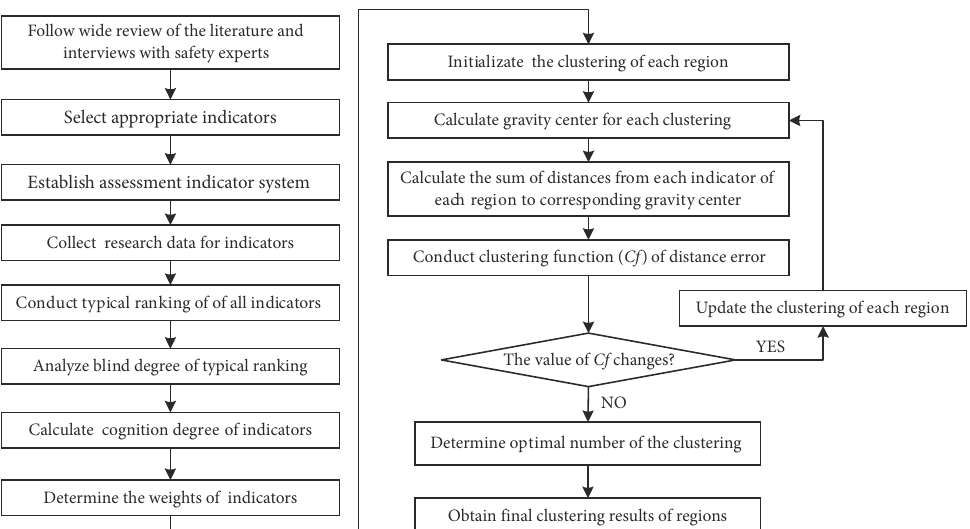
Figure 1. Framework flowchart of comprehensive assessment model on accident situations of the construction